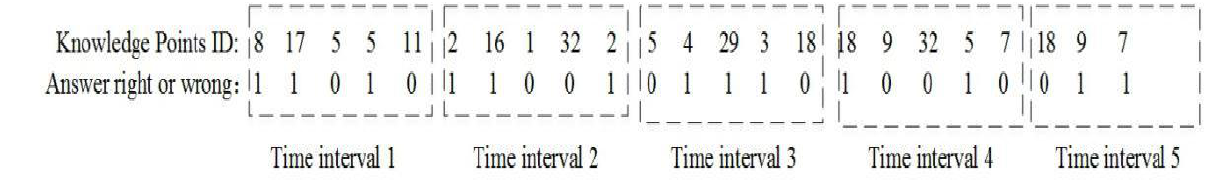
Figure 1. Time interval in the student interaction sequence.